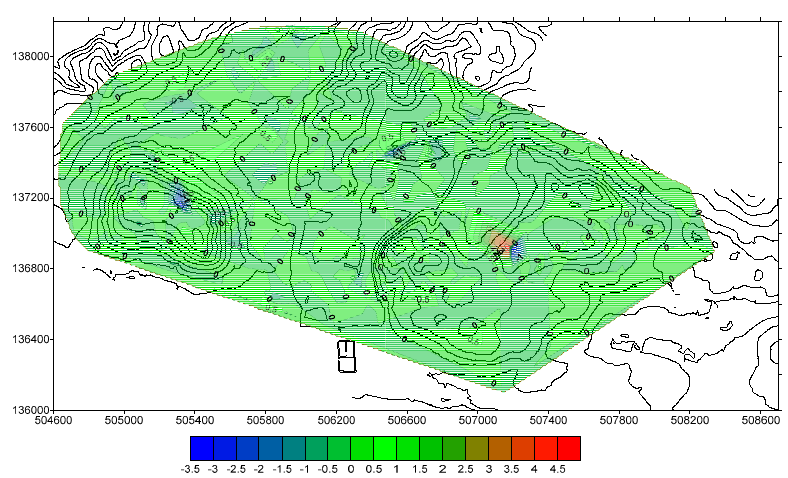
Figure 5. Residual values of KRG interpolation method for gridding ash content in layer C. Residual values are gridded with triangulation with linear interpolation method and are projected over surface contour map.